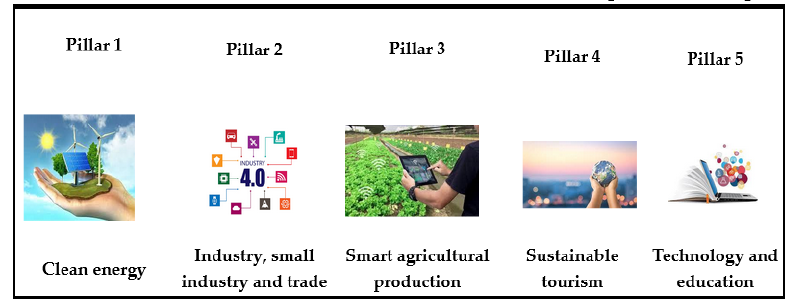
Figure 2. Five key pillars of